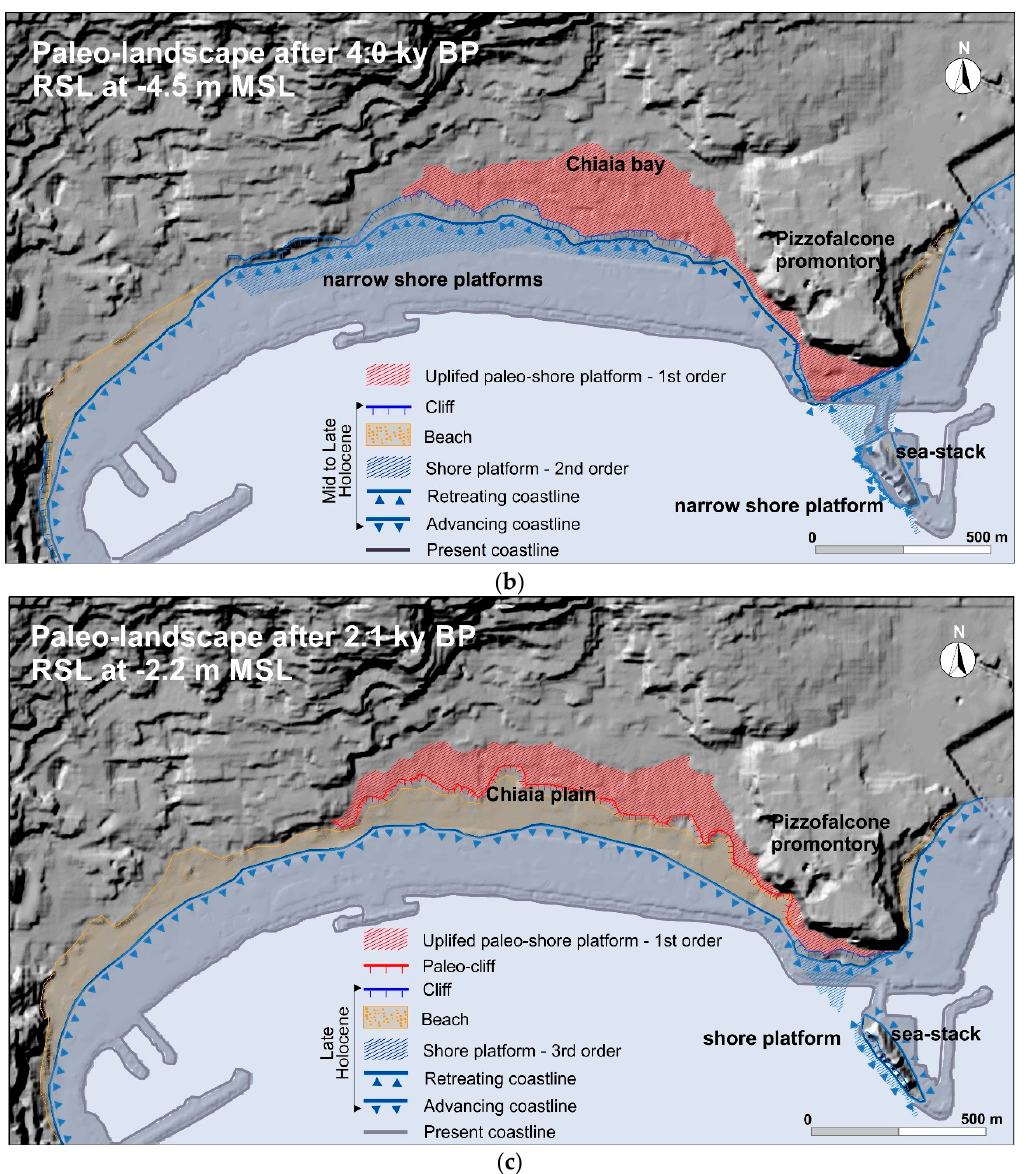
Figure 14. Morpho-evolution of Naples coastal sector since the mid-Holocene ( a ) Paleo-landscape after the Holocene marine transgression (6.5 ky BP); ( b ) Paleo-landscape after the volcano-tectonic uplift occurred 5.0–4.5 ky BP; and, ( c ) Paleo-landscape during the Roman period . A new curve of Mid-Holocene relative sea-level variation was proposed for the Naples coastal sector as a result of our geomorphological interpretations (Figure 15).